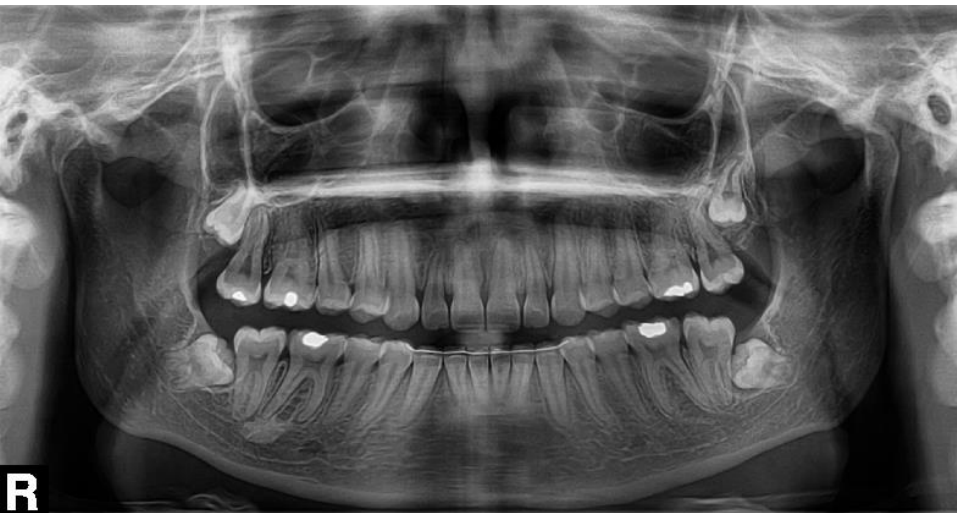
Figure 2. The orthopantomogram of the patient 1. Tooth No. 38 is semi-impacted in a mesially inclined, almost horizontal position. There is a burnout around the crown of the tooth.